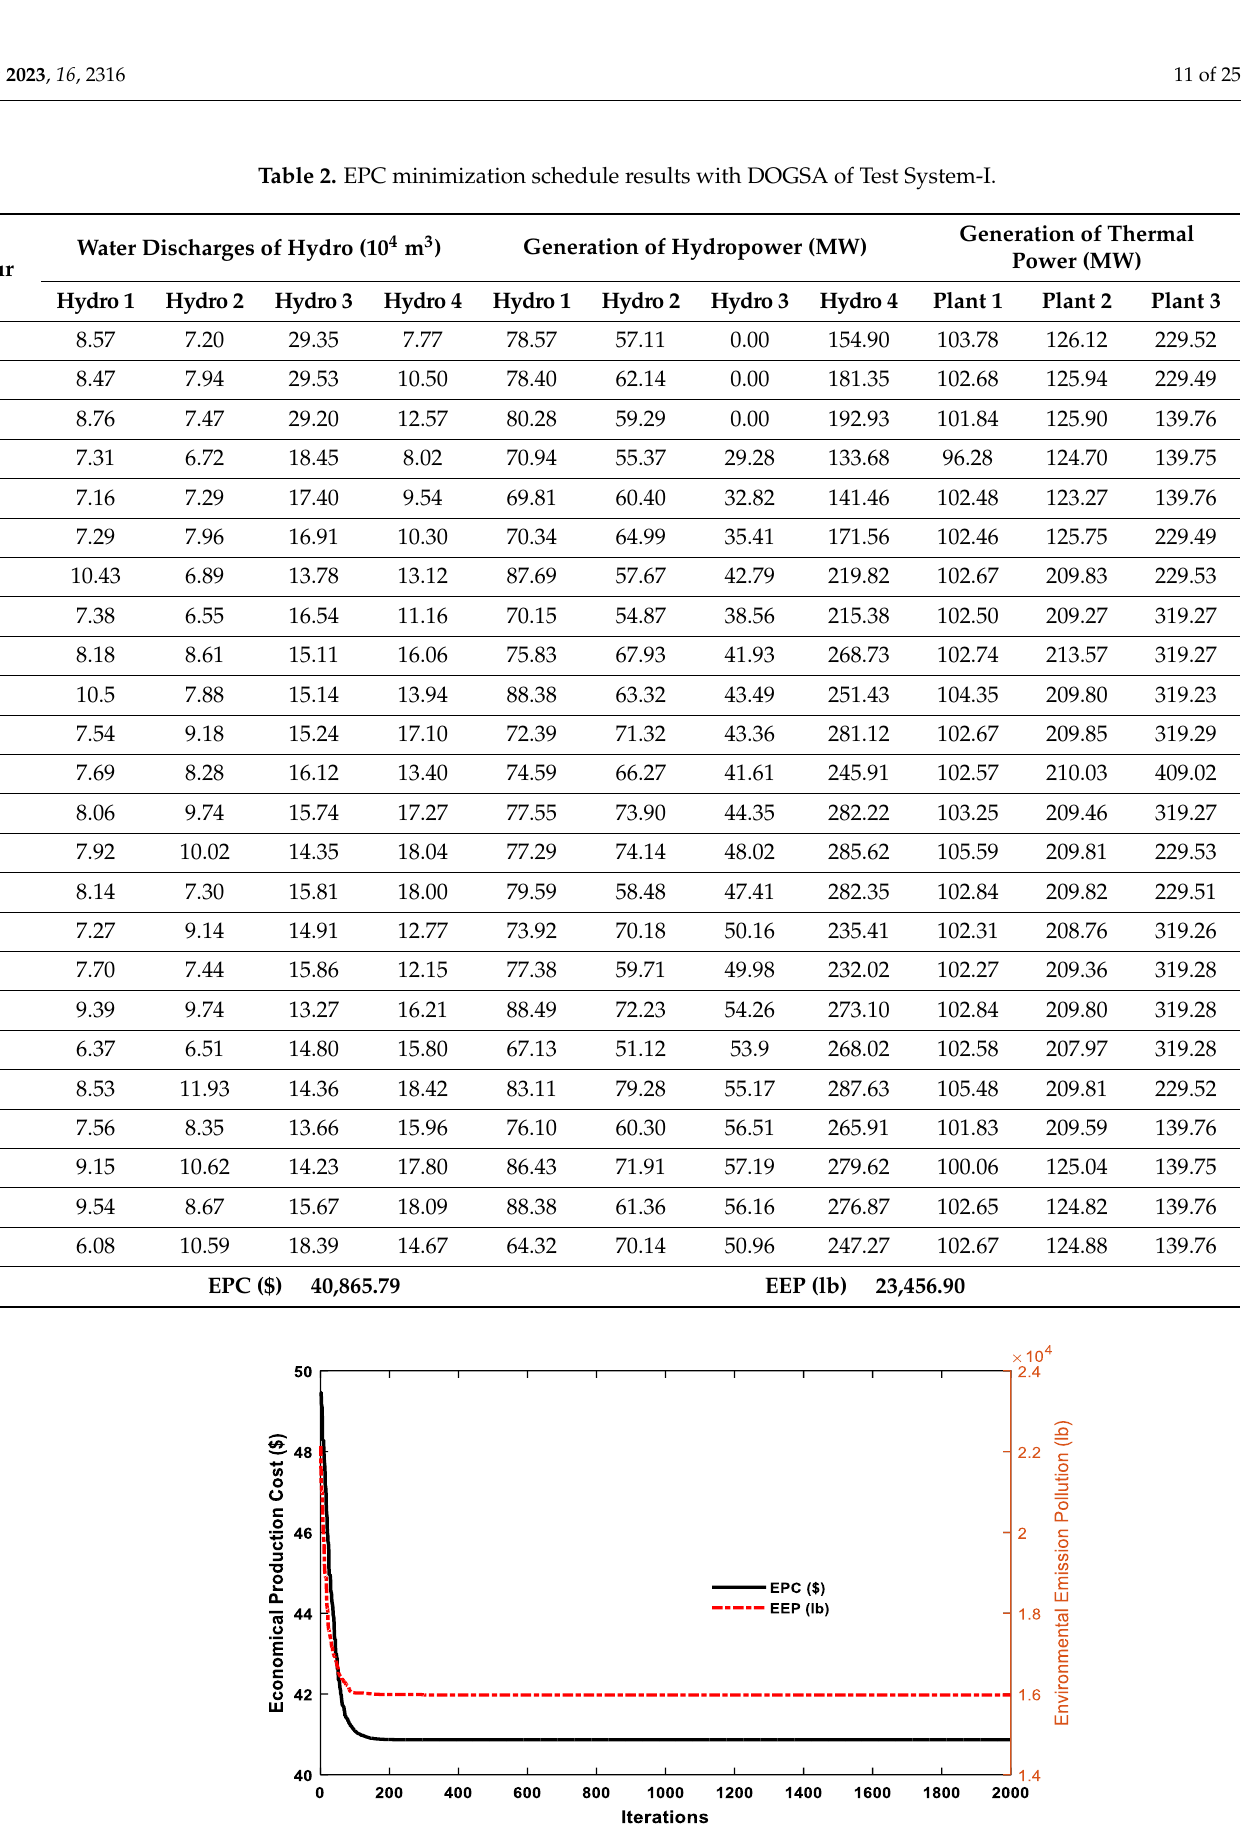
Figure 3. Performance characteristics of EPC and EEP with DOGSA for MSHTS of Test System-I.